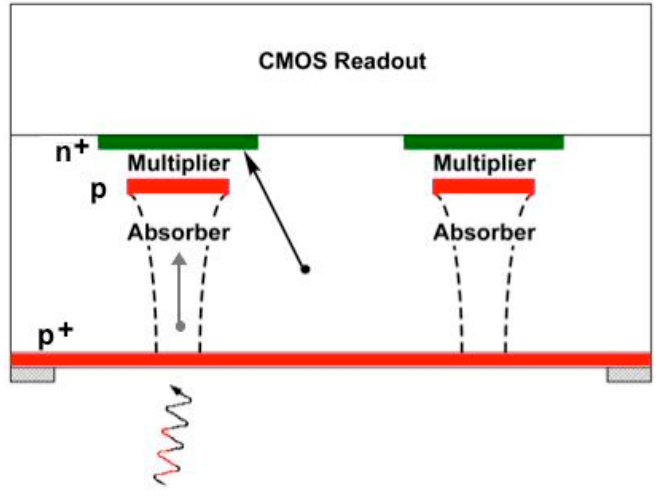
Figure 8. Low-fill-factor APD design used in lidar sensors.